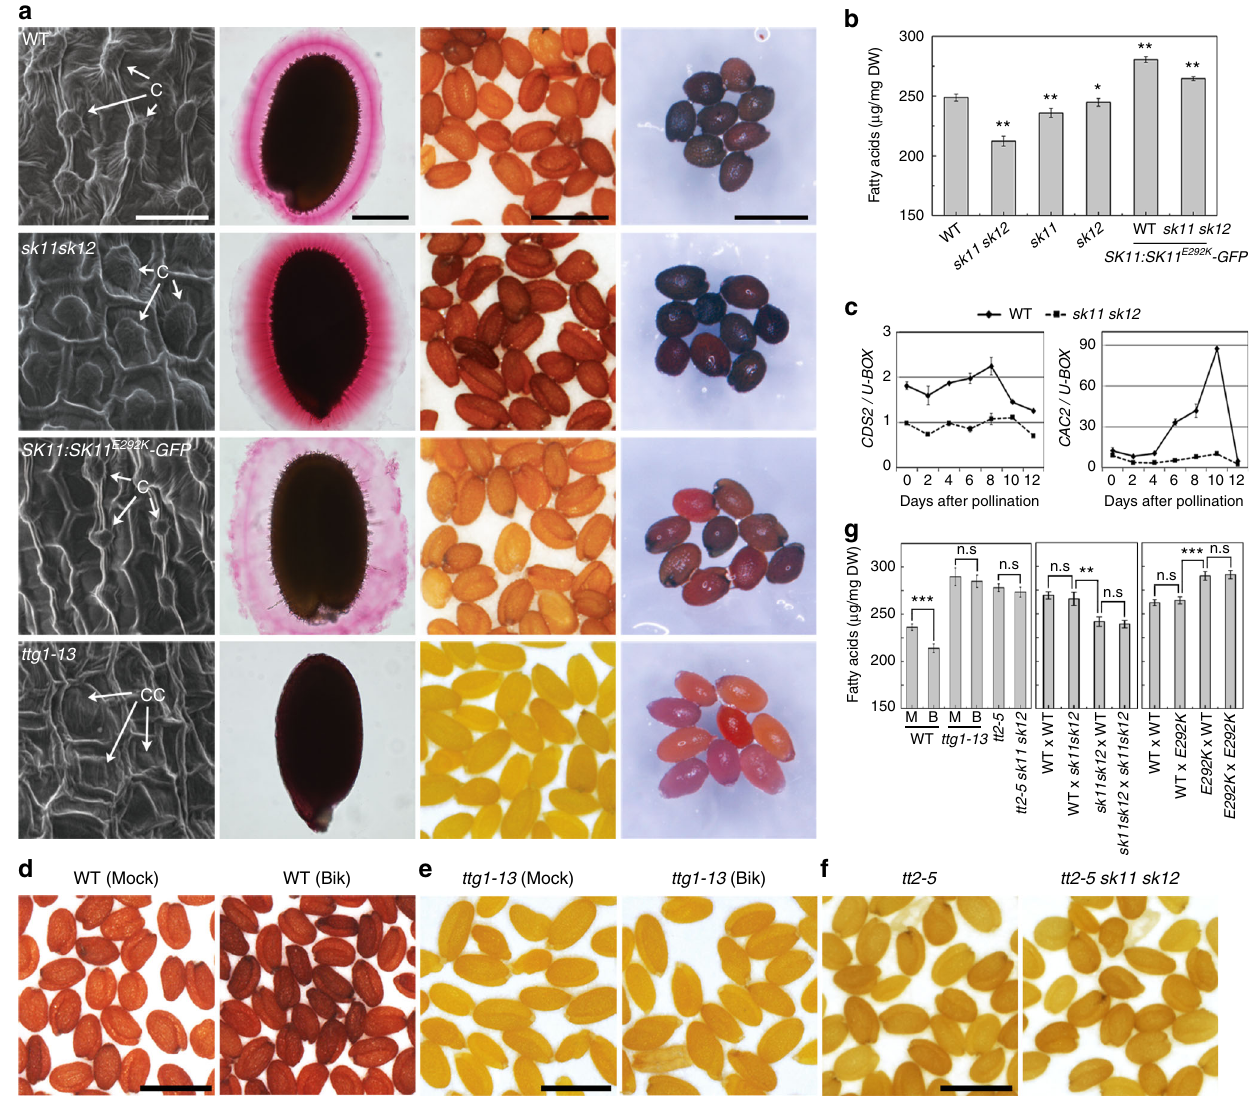
Fig. 3 Altered activity of SKs affect seed characters. a Examination of seed coat phenotypes of mature Arabidopsis seeds in various genetic backgrounds. Scanning electron microscopy (SEM) of seed coat ( fi rst column), seed coat mucilage staining with ruthenium red (second column), seed color (third column), and seed staining with p -dimethylaminocinnamaldehyde (DMACA) (fourth column) are shown in panels from left to right. Scale bars, 25 μ m, 200 μ m, 1 mm, and 1 mm (from left to right). In SEM panels, “ C ” indicates columella, while “ CC ” indicates collapsed columella. b Measurement of total fatty acid contents of mature seeds in various genetic backgrounds. Values are mean ± s.d. of three biological replicates. Asterisks indicate signi fi cant differences between wild-type and samples in other genetic backgrounds (two-tailed paired Student ’ s t test, * P < 0.05, *** P < 0.001). c Quantitative real- time PCR analysis of CDS2 and CAC2 expression in developing seeds of wild-type and sk11 sk12 plants. Results were normalized against the expression levels of U-BOX as an internal control. Values are mean ± s.d. of three biological replicates. d , e Effect of bikinin treatment on seed color of wild-type ( d ) and ttg1- 13 ( e ) mature seeds. Wild-type and ttg1-13 siliques were mock-treated (Mock) or treated with 25 μ M bikinin (Bik) at 4 days after pollination, and the resulting mature seeds were collected for further analyses. Scale bars, 1 mm. f Comparison of seed color of tt2-5 and tt2-5 sk11 sk12 . Scale bar, 1 mm. g Measurement of total fatty acid contents of mature seeds described in d – f (left panel) and mature F1 seeds from reciprocal crosses between wild-type and sk11 sk12 plants (middle panel) or between wild-type and SK11:SK11 E292K -GFP ( E292K ) plants (right panel). Values are mean ± s.d. of three biological replicates. Asterisks indicate signi fi cant differences between each speci fi ed pair of samples in different genetic backgrounds (two-tailed paired Student ’ s t test, ** P < 0.01, *** P < 0.001, no statistical difference (n.s), P > 0.05). M, mock-treated; B, (Fig. 3f) and fatty acid levels (Fig. 3g, left panel). These (Supplementary Fig. 6g). In addition, although both tt2-5 and tt8- observations suggest that both TTG1 and its interacting partner 4 seeds displayed transparent testa and reduced PA deposition, TT2 control seed characters genetically downstream of SK11 and only tt2-5 exhibited the defect in mucilage extrusion (Supple- SK12 . mentary Fig. 10) as observed in SK11:SK11 E292K -GFP (Fig. 3a). These results imply that TT2 could be more closely related to While SK11 and SK12 affect the phenotypes of seed coat that is TTG1 activity in affecting seed characters. We then created tt2-5 a maternal tissue, we also tested the origin of their effects on fatty sk11 sk12 triple mutants, and found that tt2-5 completely acid levels in seeds. Reciprocal crosses between wild-type and suppressed sk11 sk12 phenotypes pertaining to seed coat color sk11 sk12 plants (Fig. 3g, middle panel) and between wild-type